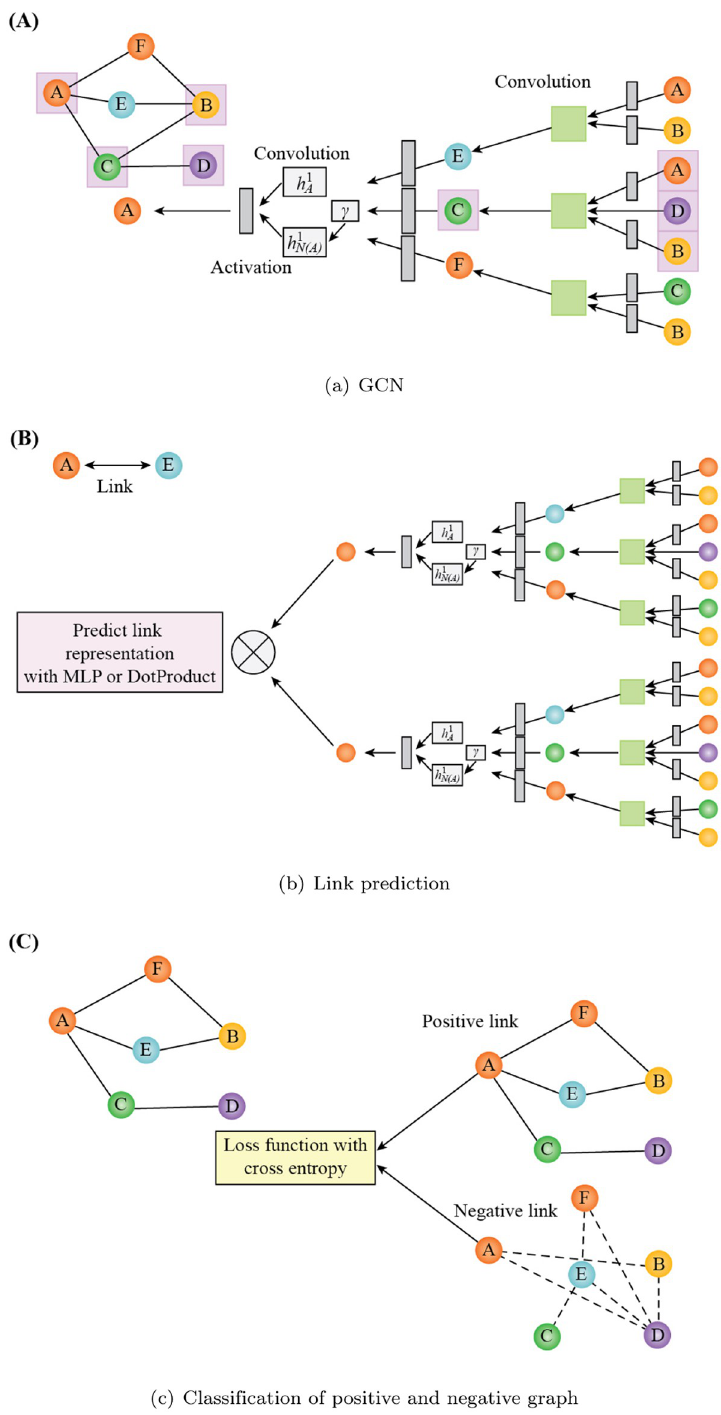
Fig 2. The architecture of the GCNMLP. (a) GCN, (b) Link prediction, (c) Classification of positive and negative graph.